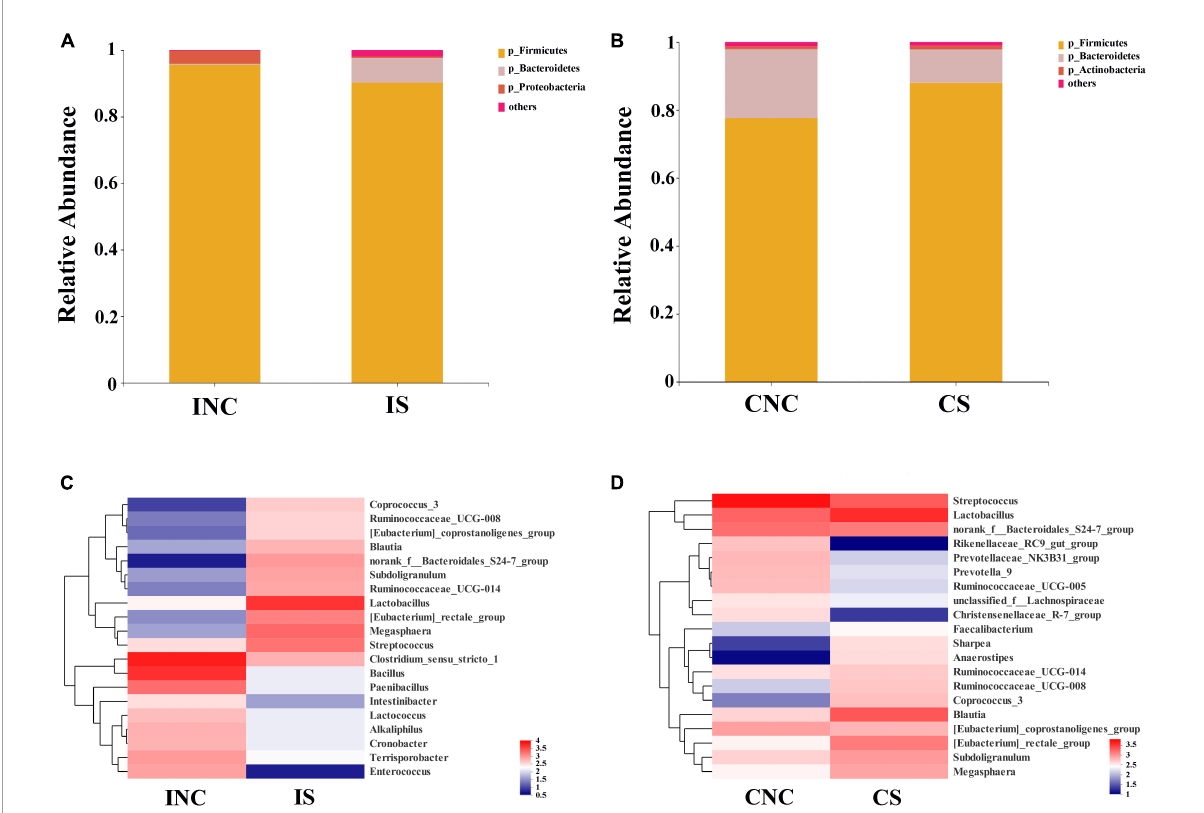
FIGURE4 Bacterial diversity at the phylum and genus level in the ileum and the colon from weaned piglets of the control and treatment group. (A) Bacterial community bar plot of INC and IS at the phylum level in the ileum. (B) Bacterial community bar plot of CNC and CS at the phylum level in the colon. (C) Bacterial community bar plot of INC and IS at the genus level in the ileum. (D) Bacterial community bar plot of CNC and CS at the genus level in colon. INC, ileum negative control; CNC, colon negative control; IS, ileum with 0.2% sodium butyrate; CS, colon with 0.2% sodium